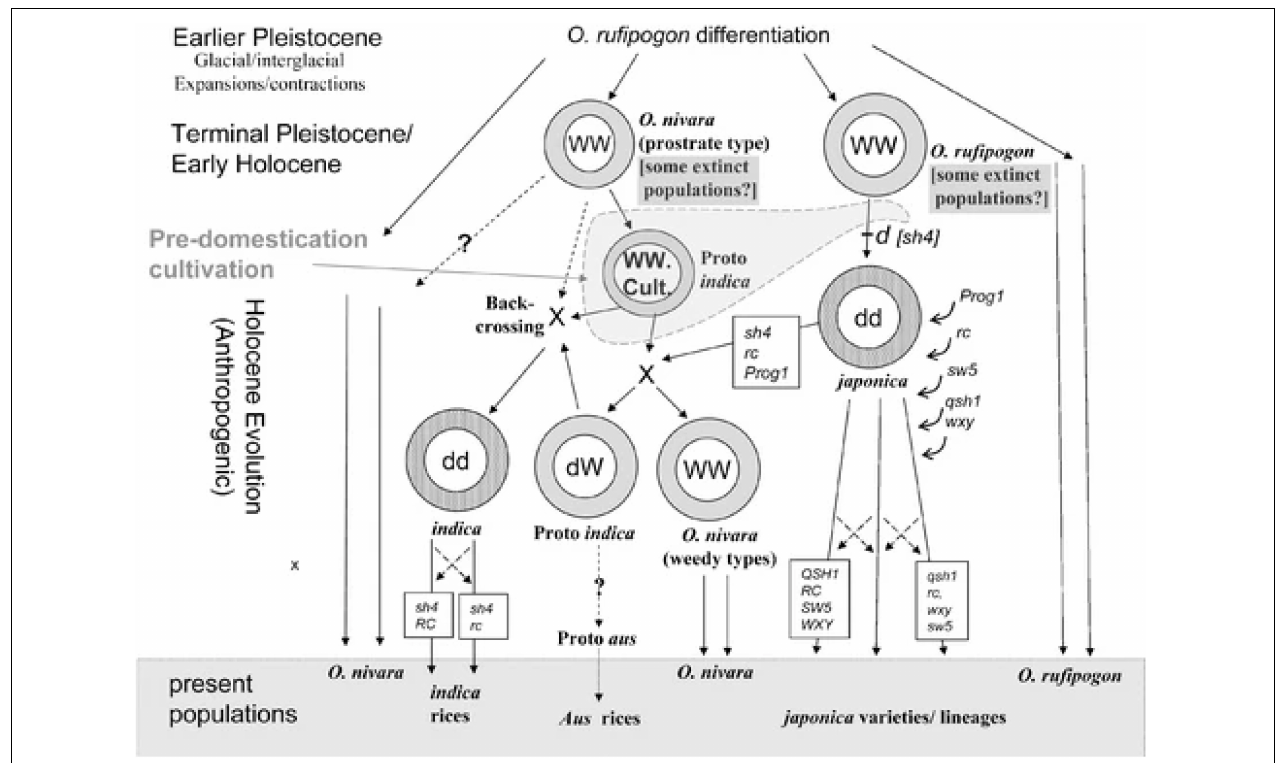
FIGURE 3 | From Kingwell-Banham (2019, Figure 3) captioned “A simplified diagram of the main evolutionary pathways to domesticated Asian rice, with selected key mutations indicated, differentiating wild-type dominant form with all capital letters and domesticated type recessive alleles with lowercase letters. Mutations: sh4,non-shattering; Prog1, erect growth; rc, white grain pericarp; sw5, wider grains; qsh1, further non-shattering; wxy, waxy/glutinous rice (low amylase); WW, wild gene pool; dd, domesticated gene pool; cult., cultivated; X, major hybridization event; crossed arrows indicate continued gene flow (introgression).” This figure from Kingwell-Banham (2019, Figure 3) shows the complexity of rice domestication and hybridization and the way the proto-indica hypothesis is conceived Fuller et al. (2010). Reprinted with permission from Springer Nature Customer Service Centre GmbH (the Licensor): Springer Nature, ARCHAEOLOGICAL AND ANTHROPOLOGICAL SCIENCES. Consilience of Genetics and Archaeobotany in the Entangled History of Rice, Fuller et al. (2010). Article hyperlink: https://doi.org/10.1007/s12520-010-0035-y (Journal homepage hyperlink: